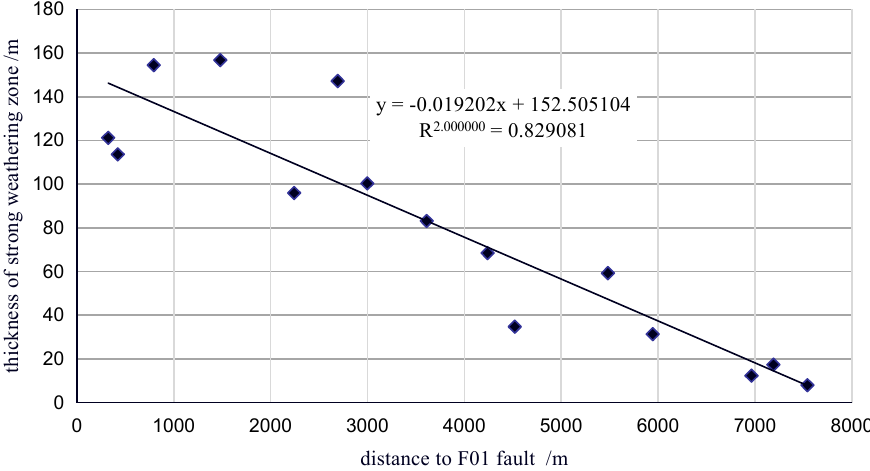
Figure 11. Relationship between thickness of strong-weathered zone and distance to F01 fault (Figure 2). The thickness data of the strong-weathered zone were obtained from integrating core, logging, and seismic data.